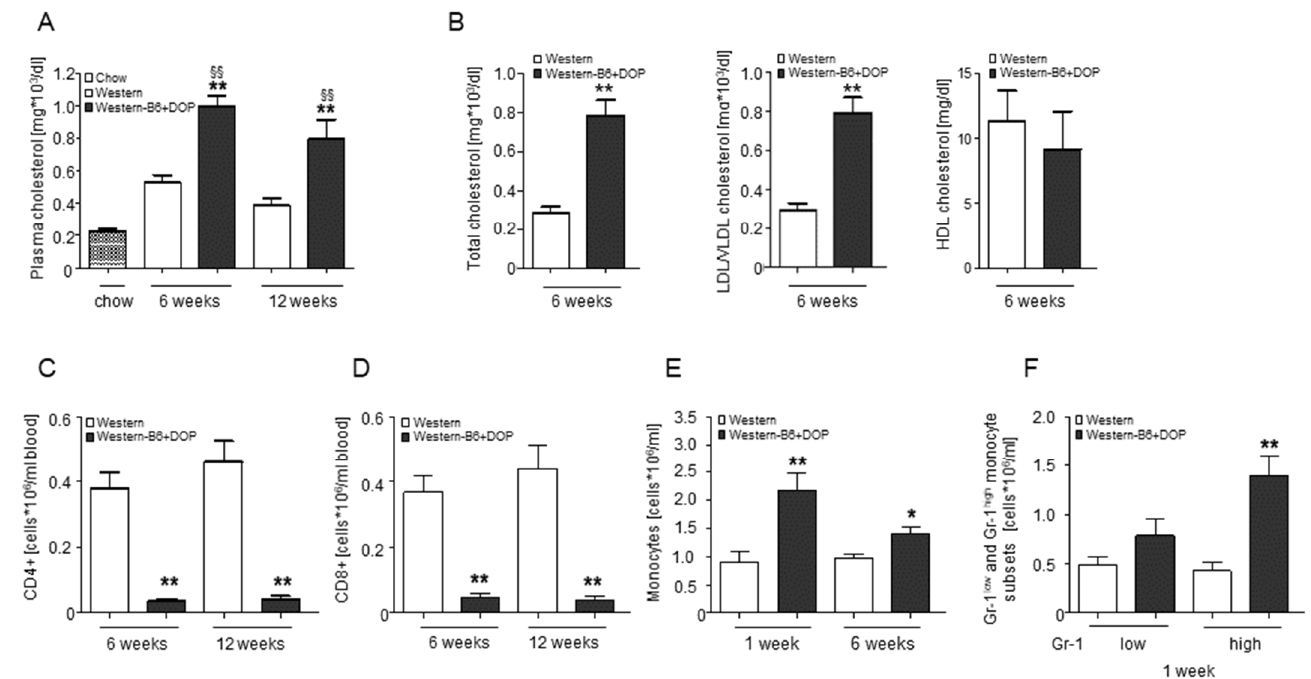
Figure 3. Lipoprotein and leukocyte alterations after S1P lyase inhibition in cholesterol-fed ApoE − / − mice. ( A ) Total plasma cholesterol levels over a period of 6 and 12 weeks. Statistically significant differences were analyzed by one-way ANOVA followed by Tukey’s post hoc test. ** p < 0.01 (DOP compared to Western) and §§ p < 0.01 (compared to normal chow-fed ApoE − / − ). ( B ) Quantification of total cholesterol, LDL/VLDL cholesterol, and HDL cholesterol in plasma samples of mice fed a Western versus Western-B6+DOP diet after 6 weeks. Statistically significant differences (Student’s t -test) are indicated as ** p < 0.01. All results are shown as mean ± SEM. ( C ) and ( D ) Severe lymphopenia as observed by the decline in CD4+ T-lymphocytes and CD8+ T-lymphocytes after DOP treatment. ( E ) Monocytosis and ( F ) quantification of F4/80 + CD115 + Gr-1 high and low monocyte subsets in peripheral blood. Results are shown as mean ± SEM. Statistically significant differences from controls were analyzed by Student’s t -test; * p < 0.05; ** p < 0.01Western compared to Western-B6+DOP).